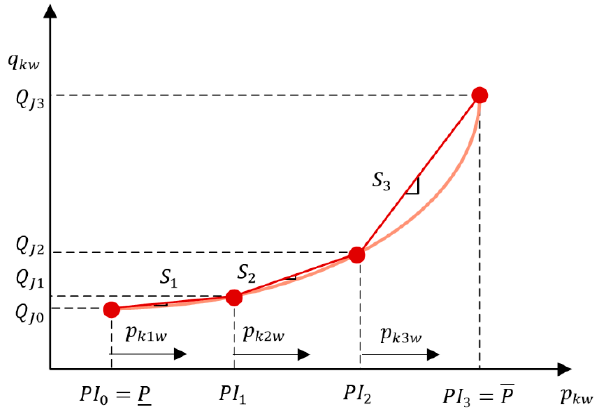
Figure 4. Example of three ‐ block piecewise linear approximation of the heat rate curve.